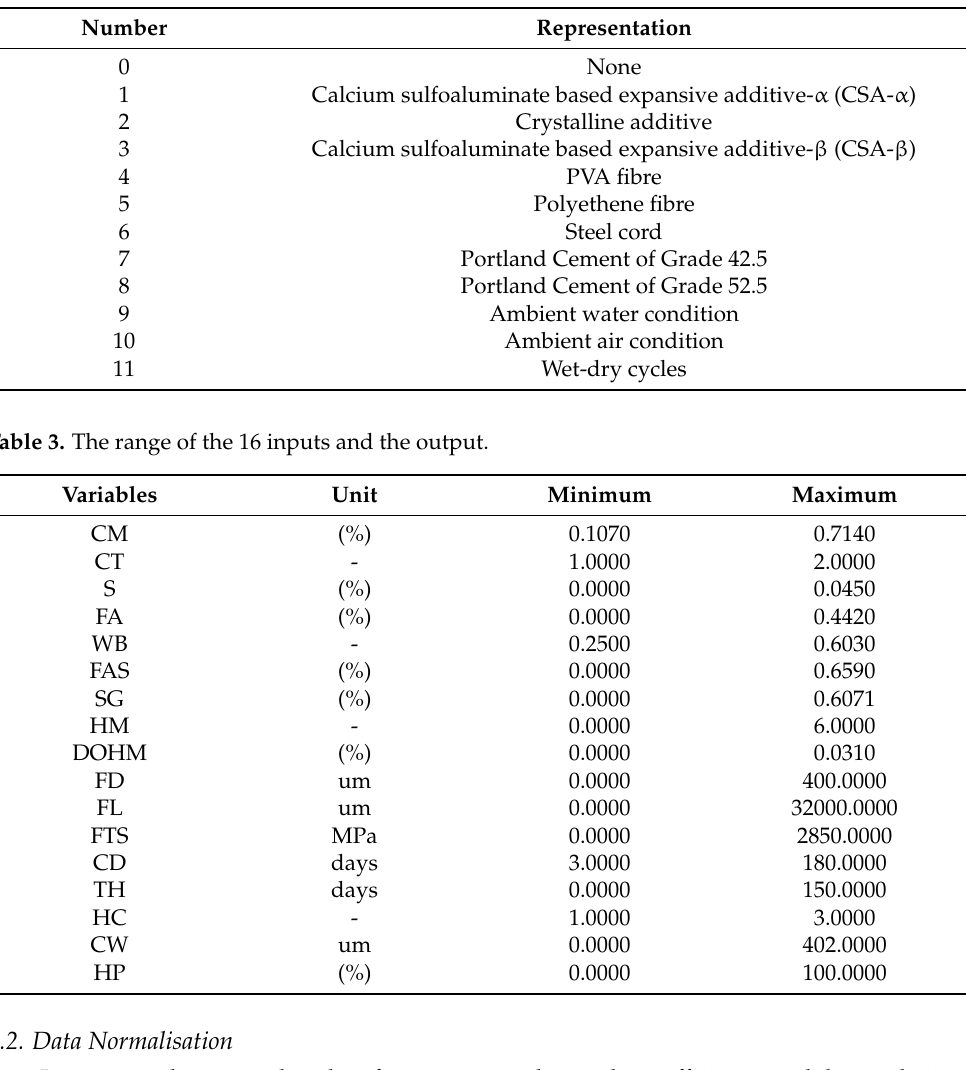
Table 2. The representation of numbers of healing materials, the cement type and healing conditions.